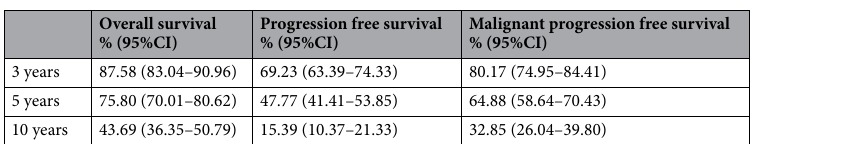
Table 3. Overall survival, progression free survival and malignant progression free survival at 3, 5 and 10 years after surgery. Table showing overall survival, progression free survival and malignant progression free survival at 3, 5 and 10 years after